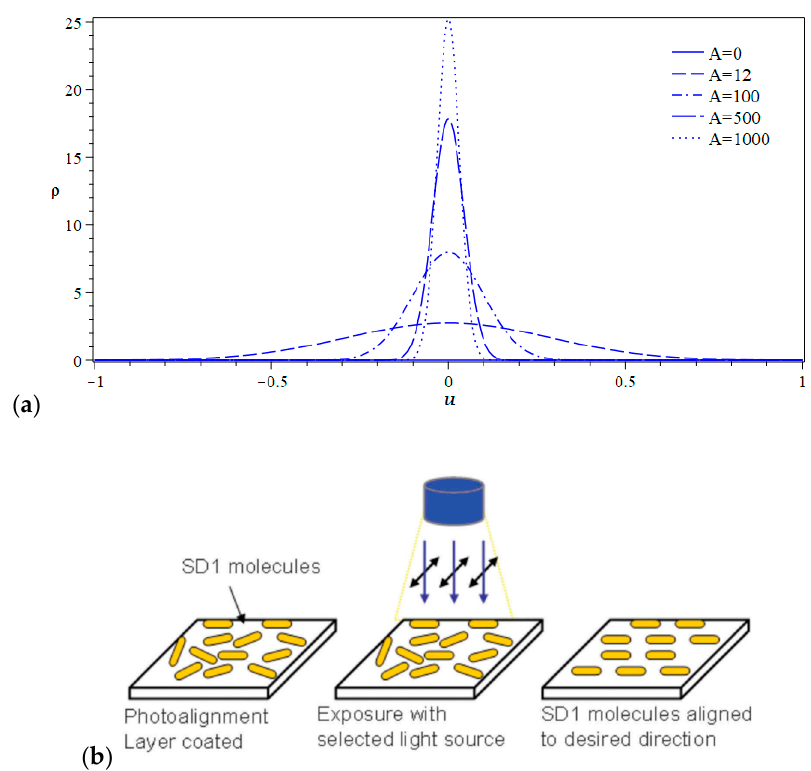
Figure 1. ( a ) Distribution function ρ ( u ) of the azo dye molecules for different values of parameter A ; ( b ) schematic representation of the photoalignment technique.